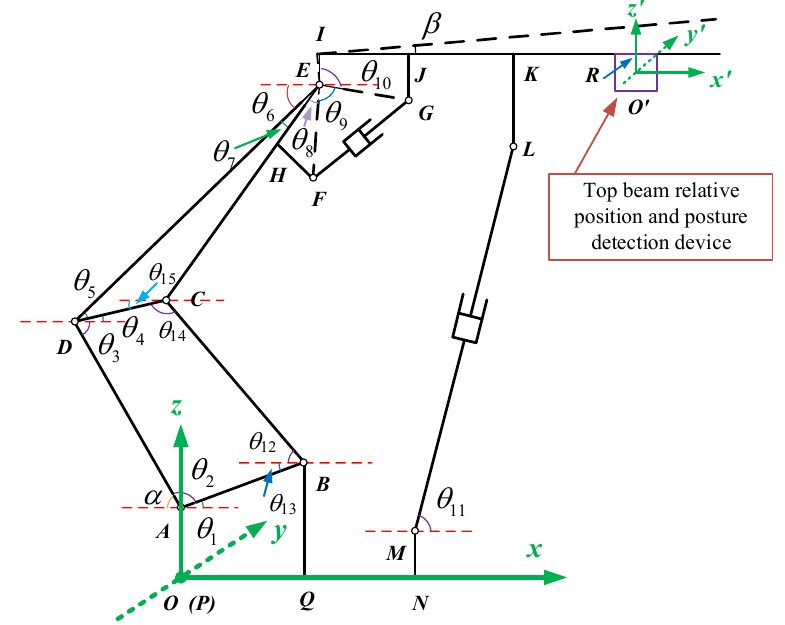
Figure 2. Schematic diagram of hydraulic support posture control.